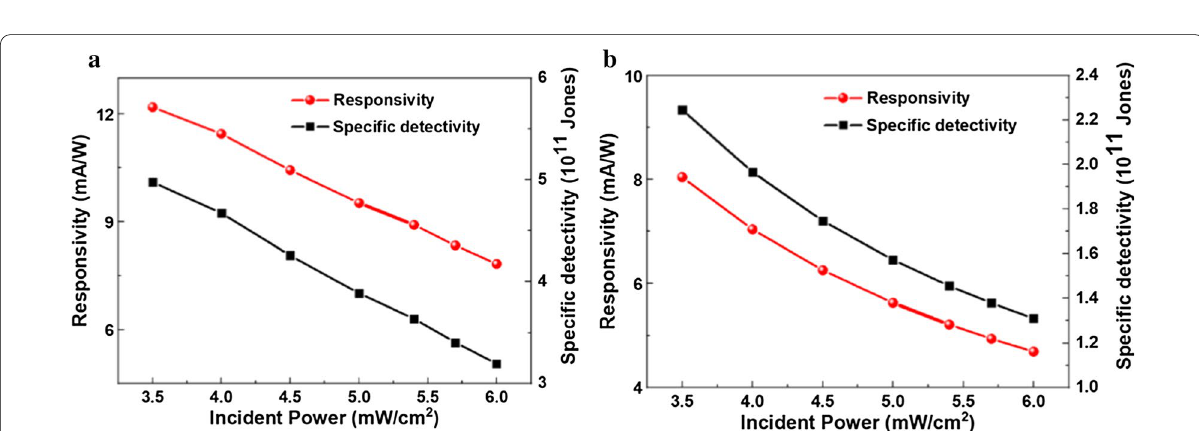
Fig. 4 Responsivity and specific detectivity of CsPbI x Br 3